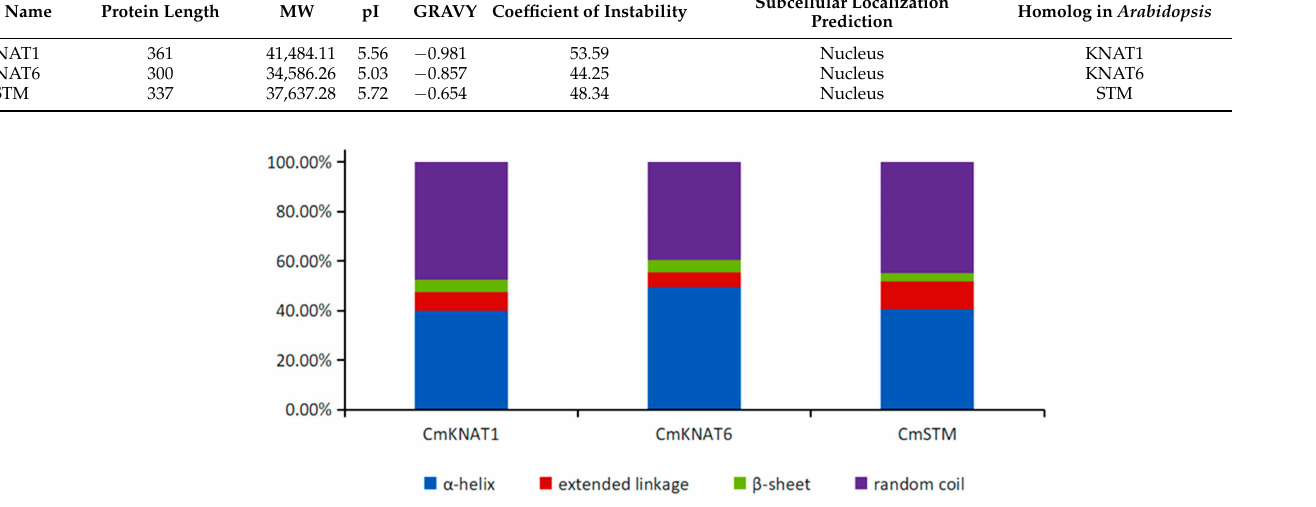
Figure 2. Prediction of secondary structure of KNOX proteins in chrysanthemum. Table 2. Prediction of phosphorylation sites of KNOX proteins in chrysanthemum.